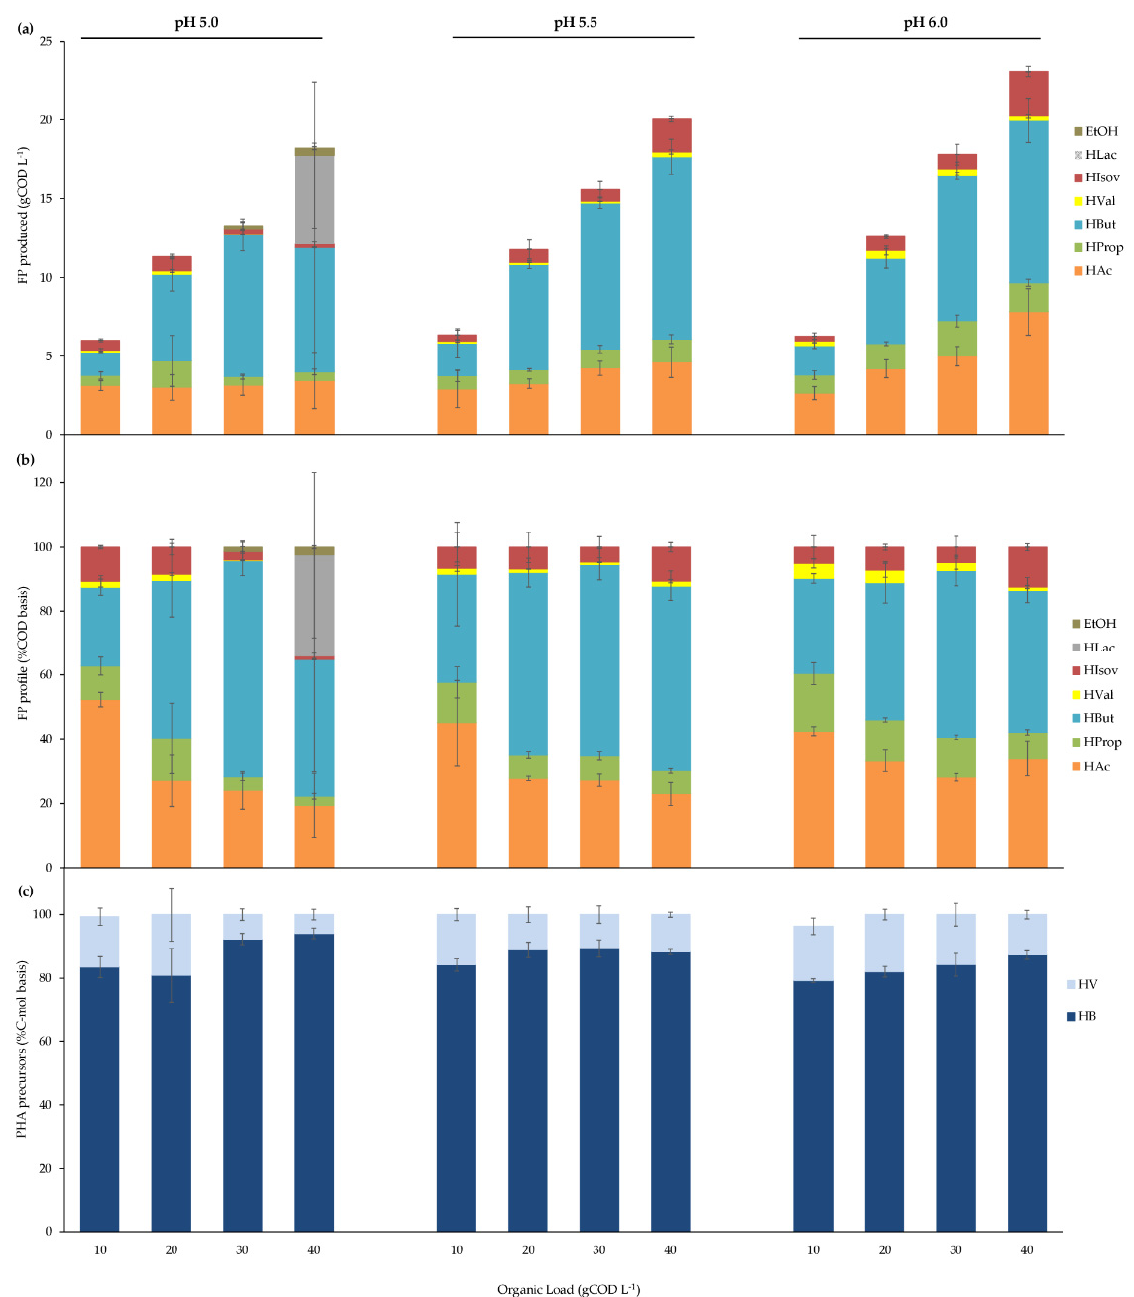
Figure 3. ( a ) Fermentation products produced and ( b ) fermentation products profile obtained at each different pH (5.0, 5.5 and 6.0) and at each different organic load (10, 20, 30 and 40 gCOD L − 1 ); ( c ) Estimated PHA precursors at each condition tested. Error bars represents standard deviations.